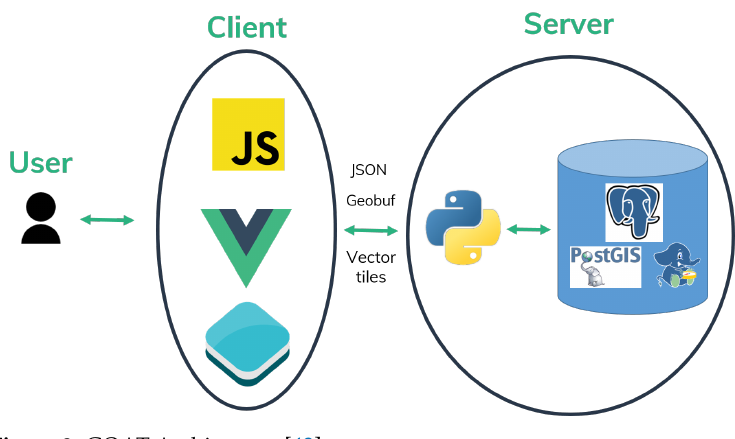
Figure 3. GOAT Architecture